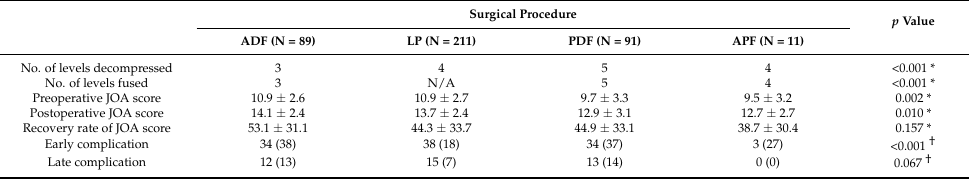
Table 5. Comparisons of surgical outcomes stratified by surgical procedures.